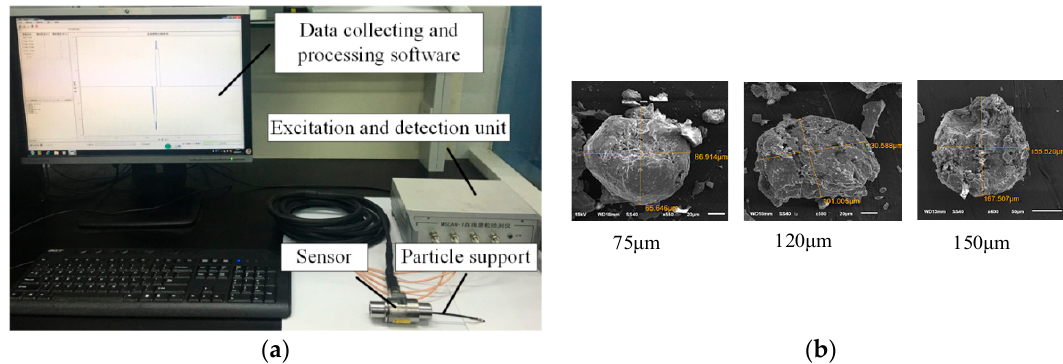
Figure 9. Experimental system. ( a ) The particle detection system, ( b ) the selected iron particles. Table 3. The core parameters of the sensors adopted in the experiments.